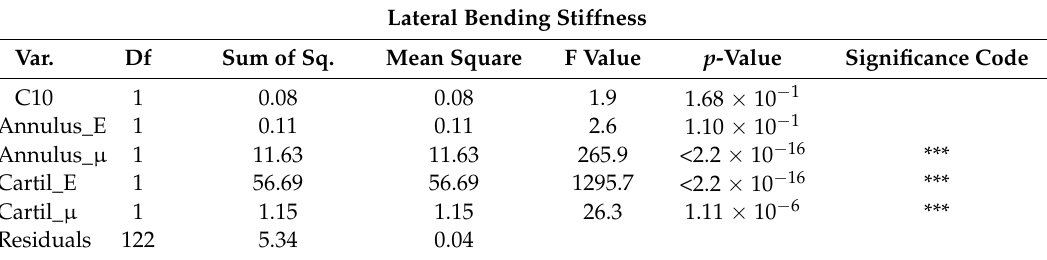
Table 21. ANOVA table for a lateral bending stiffness linear model. Lateral Bending Stiffness